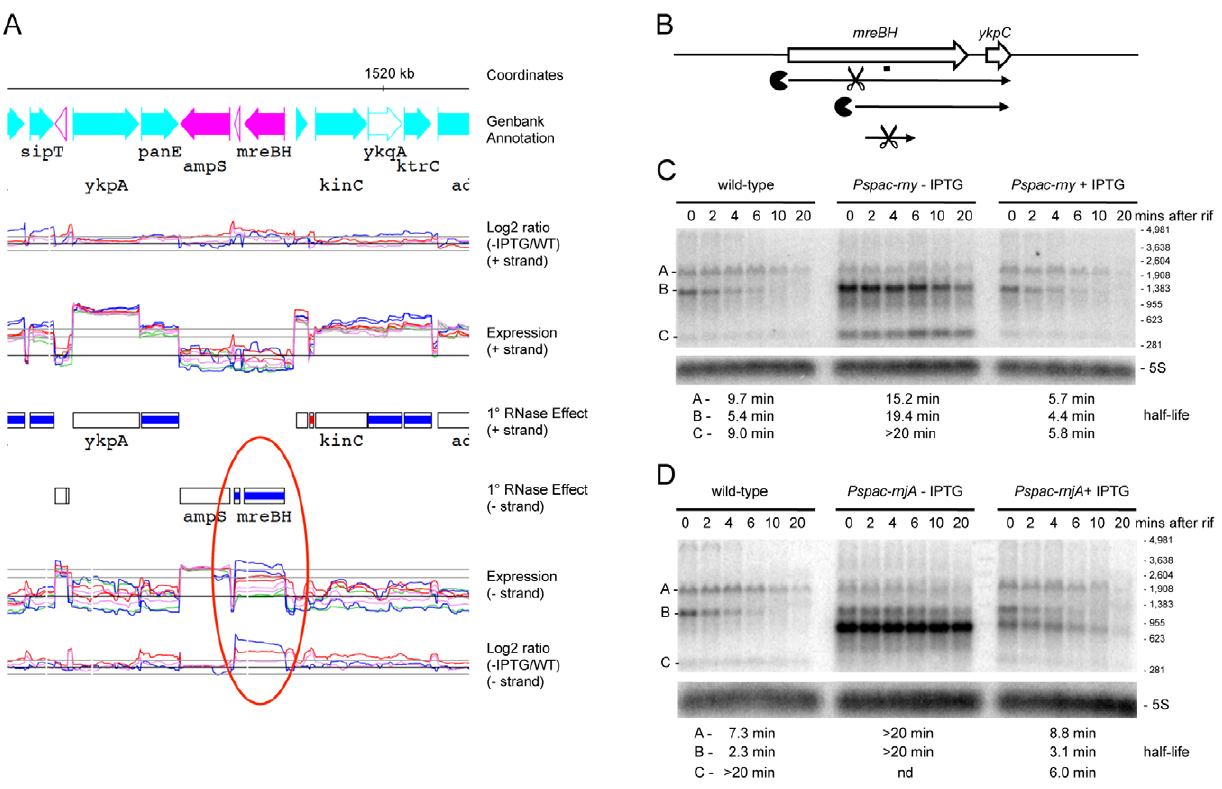
Figure 4. Degradation of the mreBHykpC mRNA depends on both RNase Y and J1. (A) Example of trace of the expression data around the mreBH ykpC locus. Lanes are as follows (from top to bottom): (1) Genbank annotation, (2) effect of the depletion of each RNase (log2 ratio 2 IPTG to wt, calculated on normalized values) on the positive strand, (3) expression signal of wt and RNase depleted strains (normalized log2 values) on the positive strand, (4) summary of the gene-level statistical analysis showing primary (1 u ) RNase effect (5) expression signal on the negative strand, (6) effect of the depletion of each RNase on the negative strand. The color code for experiments is: wild-type, green; RNase III, violet; RNase J1, blue; RNase Y, red. In the plots of expression signal (lanes 3 and 5), the horizontal black line represents the global median over the whole chromosome and the two horizontal gray lines indicate 5 6 and 10 6 this value. In the plots of log2 ratios, the horizontal black line corresponds to base-line (no change) and two horizontal gray lines on either side indicate 2 6 up and 2 6 down changes. The summary of the gene-level statistical analysis shows which genes or expression segments were affected by the depletion of at least one of the three RNases: thick green line, gene showing decreased expression in at least one RNase depletion experiment; thick violet, blue or red line, gene showing increased expression in at least one RNase depletion experiment (in this case, the color indicates which depletion was observed to have the greatest effect); thick gray line, gene showing both increased and decreased expression depending on the RNase considered. Color codes for the Genbank annotation are as follows: cyan and magenta, annotated protein coding sequences on the positive and negative strands, respectively (solid symbol when function is known; hollow symbol when function is considered unknown in Genbank); red, ribosomal RNA; dark blue, tRNA; green, Misc_RNA. Traces were plotted using MuGen [43]. Only the signal from unique oligos are shown; gaps are due to non-unique genome sequences. Note: care should be taken when interpreting the log2 ratio signal on the non-coding strand because ratios of values close to background do not have a direct biological interpretation. In particular, these ratios are affected by artifacts such as those caused by reverse transcriptase copying of the cDNA strand, despite the presence of 40 m g/mL actinomycin D in this step. (B) Structure and predicted degradation pathway(s) of the mreBH ykpC transcript. ORFs are shown as large white arrows, transcripts as thin black arrows. Scissors indicate cleavage by RNase Y, ‘Pacman’ symbols represent 5 9 -3 9 degradation by RNase J1. A short thick line indicates the position of the probe used. (C) Northern blot of total mRNA isolated at times after addition of rifampicin (rif) from wild-type and RNase Y depleted ( Pspac-rny 2 IPTG) and RNase Y induced ( Pspac-rny + IPTG) cells. The blot was probed with 5 9 -labeled oligo CCB832 (Table S6) and reprobed with oligo HP246 against 5S rRNA. The half-lives of the different RNA species (A, B, C) from the mreBH ykpC are given under the Northern blot. Migration positions of RNA markers are shown to the right of the blot. (D) Northern blot of total mRNA isolated at times after addition of rifampicin (rif) from wild-type and RNase J1 depleted ( Pspac-rnjA 2 IPTG) and RNase J1 induced ( Pspac-rnjA + IPTG) cells. Description as in panel (B); nd is not detected. their existence and shows the power of using RNase mutants for optimal condition for the expression of most regulatory RNAs, we their detection. Two examples are shown in Figure 8 and others suspected that, in the absence of key RNases, many such RNAs would be sufficiently stabilized to permit their detection. The tiling region between yrzF and yrzH (Figure S1; 2841 kb) expresses a array experiment indeed permitted the detection about 20 potential trans -acting regulatory RNAs (Table S4, ‘‘indep’’ and conditions of RNase J1 depletion. Likewise, the negative strand of ‘‘indepMT’’) not seen in the Rasmussen and Irnov studies [20,25]. the yhbF-prkA intergenic region (Figure S1; 973 kb) expresses a Most of these RNAs were also detected in a separate tiling array potential , 170 nt sRNA named S313 that is stabilized in an study of over a hundred different growth conditions and have RNase Y mutant in the absence of IPTG. In the absence of been given a ‘segment’ number (S) according to their order of RNase J1, a slightly shorter species ( , 150 nt) is stabilized. This appearance on the B. subtilis genome (Nicolas et al. , unpublished pattern is consistent with RNase Y cleavage about 20 nts from data). The present study provides an independent validation of